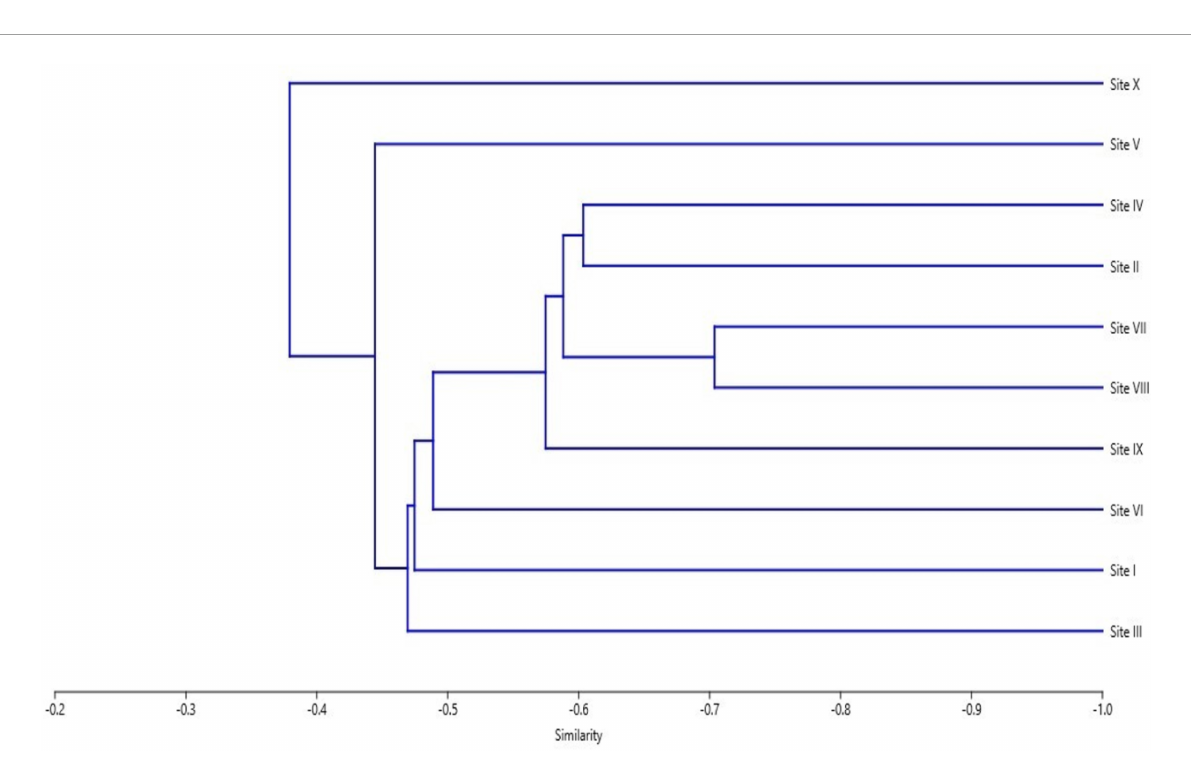
FIGURE5 Bray-Curtis (Similarity) index among selected sites of the study